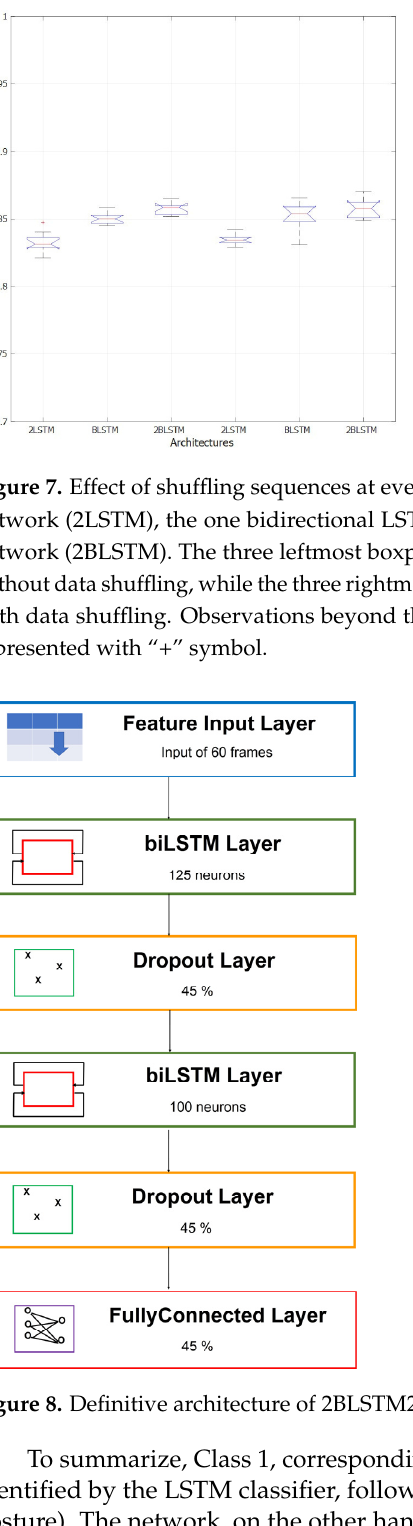
Figure 6. Accuracy distribution over 30 repetitions of 50-epochs training for different network ar- chitectures and dropout fixed at 45%. Tested architectures: one hidden bidirectional LSTM layer (BLSTM), two LSTM layers (2LSTM), one LSTM layer (LSTM), one LSTM layer followed by two fully connected layers (LSTM-2FC), two bidirectional LSTM layers (2BLSTM), two bidirectional LSTM layers with two dropout layers (2BLSTM2D), two bidirectional LSTM layers with one drop- out layer (2BLSTM1D). Observations beyond the whisker length are marked as outliers and they are represented with “+” symbol.